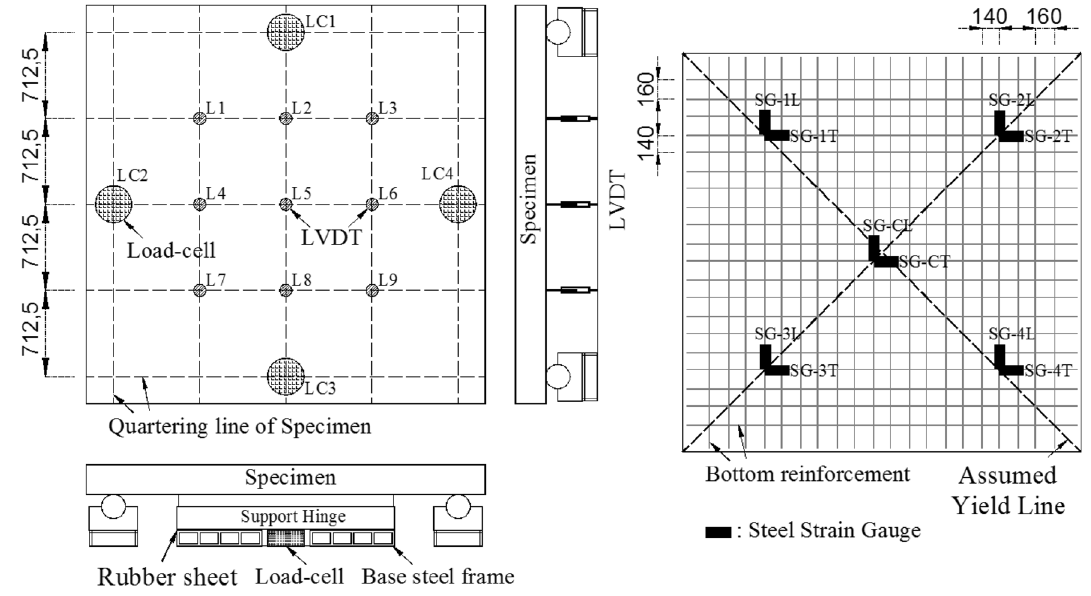
Fig. 6 Details of measurement plan (unit: mm).